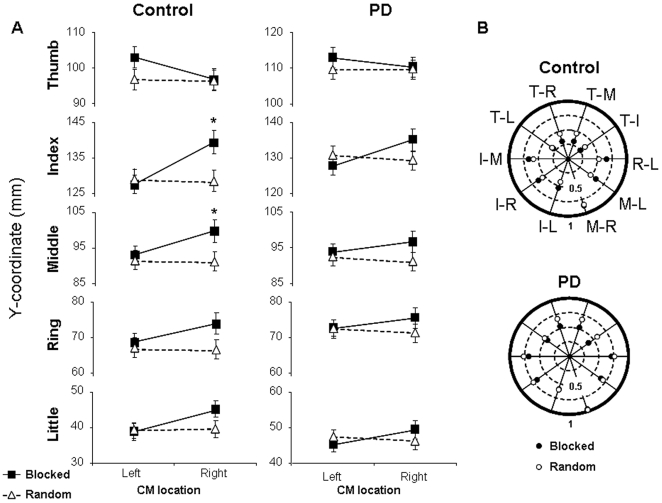
Individual fingertip contact points and covariation of digit pair contact points.Panel A depicts fingertip vertical location relative to the base of the cylinder for each digit as a function of CM location and predictability condition for controls and PD patients (left and right columns, respectively). The scale of the vertical axes is the same for all plots to allow comparison across digits. Data are means ± SE of all subjects. Asterisks denote a significant difference at p<0.05. Panel B represents the magnitude of the correlation coefficient (Pearson's r) of digit pair contact points for the controls and PD patients (top and bottom polar plots, respectively). The r-values shown in each polar plot were averaged across all subjects (after z-normalization). Values nearing zero, i.e., closer to the center of the polar plot, represent greater independence of digit pair contact points than values nearing one. White and black circles denote random and blocked conditions, respectively. T, I, M, R and L denote thumb, index, middle, ring and little fingers, respectively. Note that for digit pair correlations with similar values for blocked and random, it may appear as a single white circle.